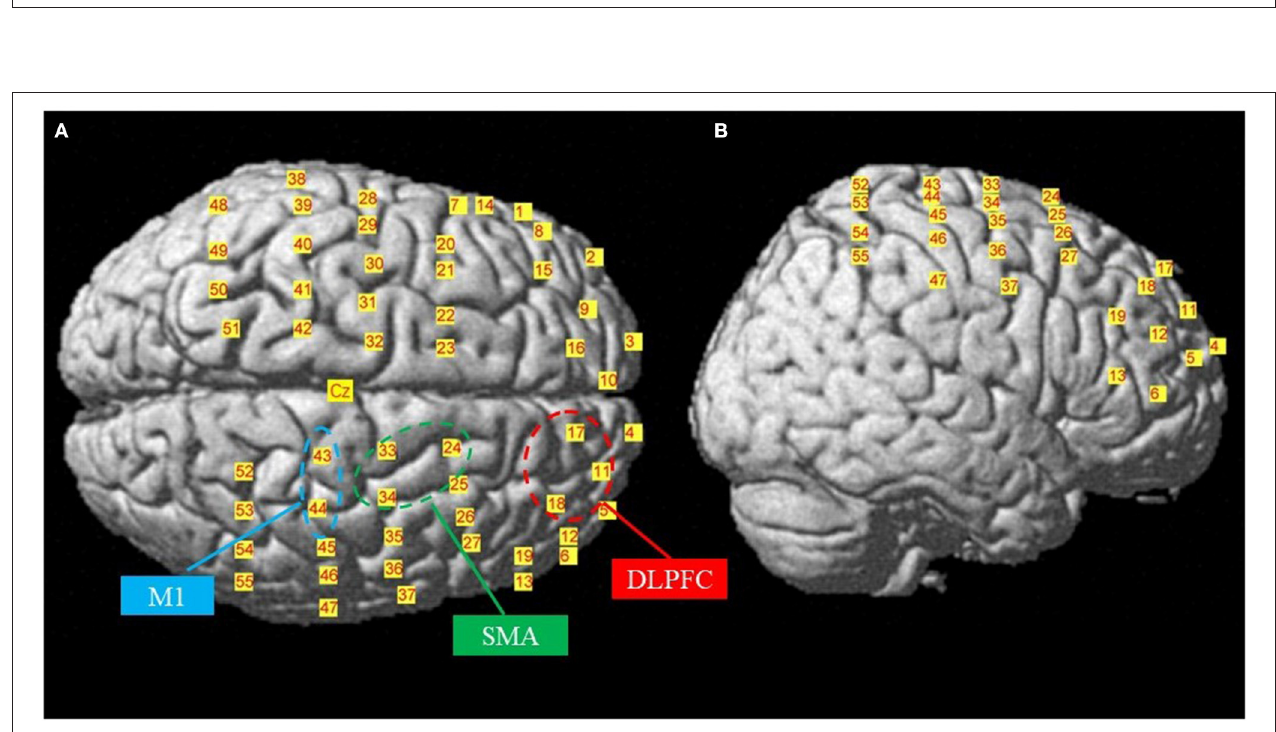
FIGURE 2 | The locations of the channels. Top (A) and right-lateral (B) views of the locations of the channels in the MNI brain. SMA, supplementary motor area; M1, primary motor cortex; DLPFC, dorsolateral prefrontal cortex.